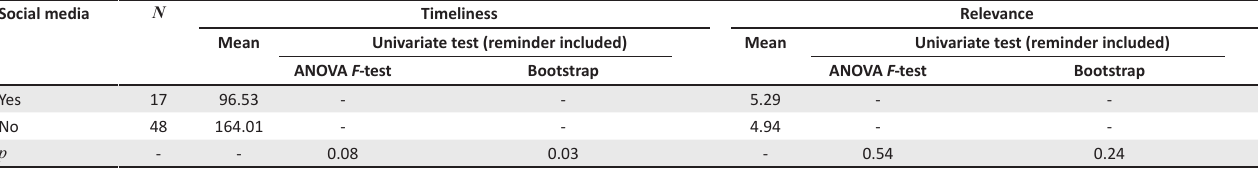
TABLE 9: Univariate results of social media. Social